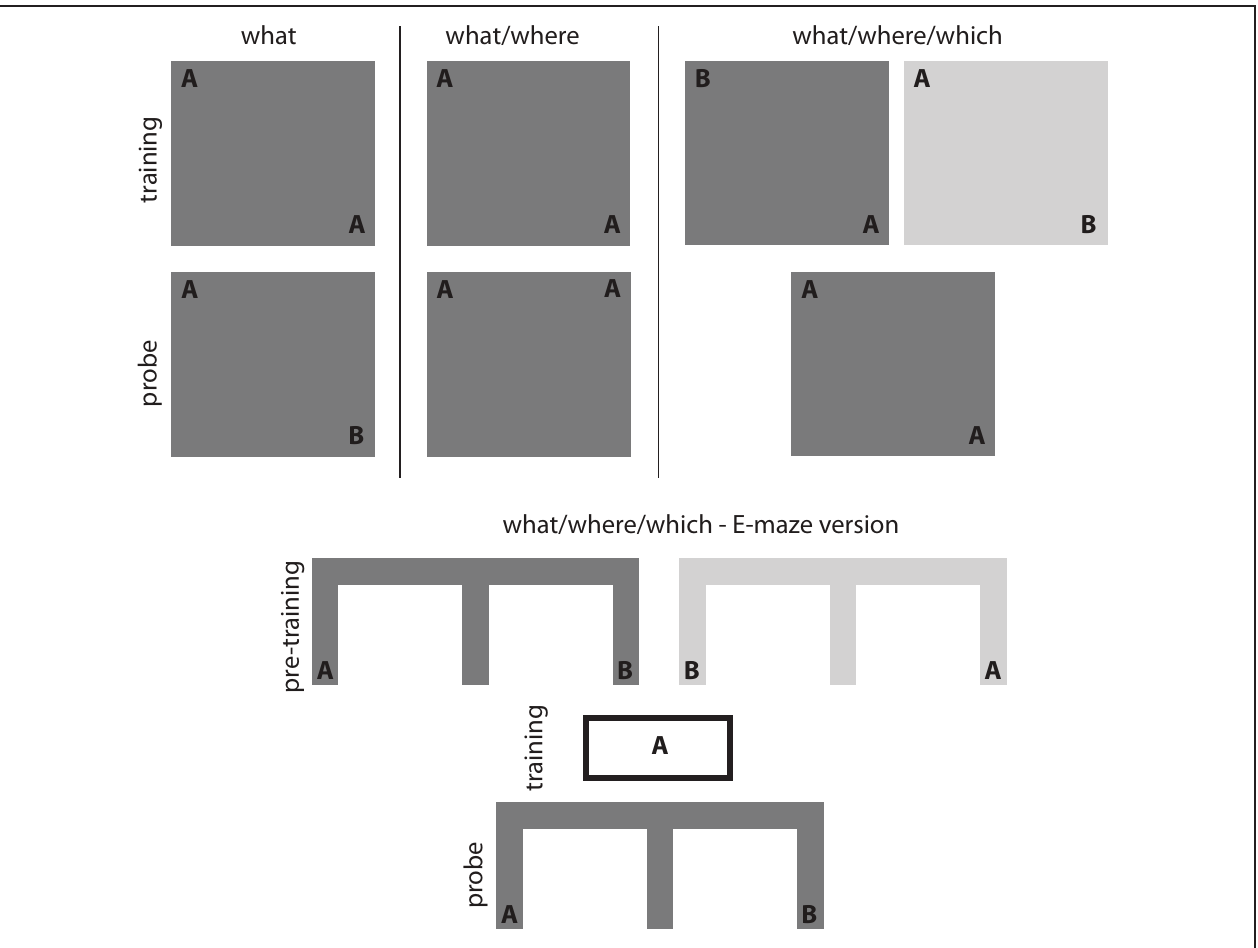
FIGURE 1 | Exploration-based recognition tasks. Simple object recognition can be assessed using what tasks in which an animal is familiarized with an object during an initial training session. Recognition memory is then assessed by measuring the difference in exploratory behavior associated with a novel object (compared to a familiar control object) during the probe session. Associations between objects and spatial locations can be assessed using what/where tasks in which an animal is familiarized with a number of identical objects distributed throughout an arena during an initial training session. Recognition memory for the object-place associations is then assessed by measuring the difference in exploratory behavior associated with the object in a novel position (compared to an object in a familiar control position) during